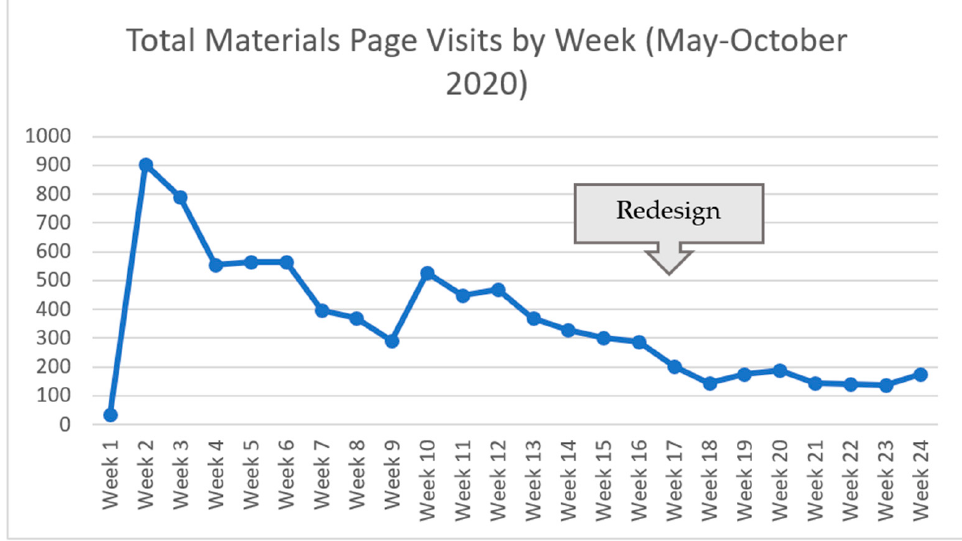
Figure 6. Total RRN materials page visits by week (May–October 2020).